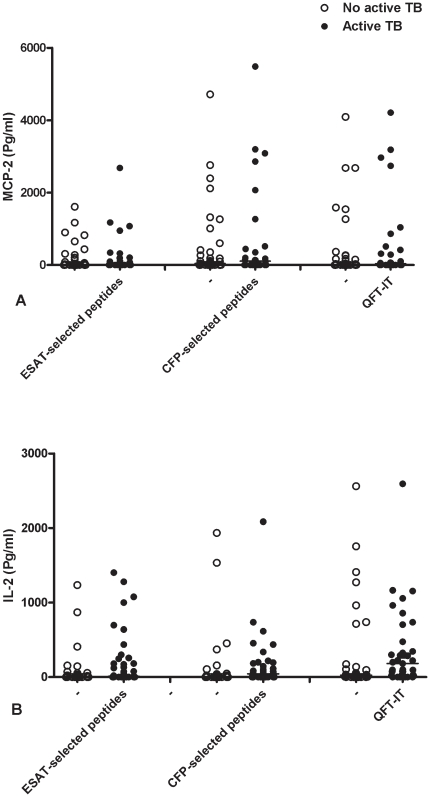
IL-2 and MCP-2 production in response to RD1 selected peptides and QFT-antigen in HIV-infected individuals.IL-2 (A) and MCP-2 (B) release in response to the RD1 selected peptides and QFT-antigen was evaluated at day 1 in the whole blood of patients with or without active TB. Horizontal lines indicate the median production. White circles indicate the individuals without active TB, black circles indicate the patients with active TB. No significant differences were found among the different comparisons performed.